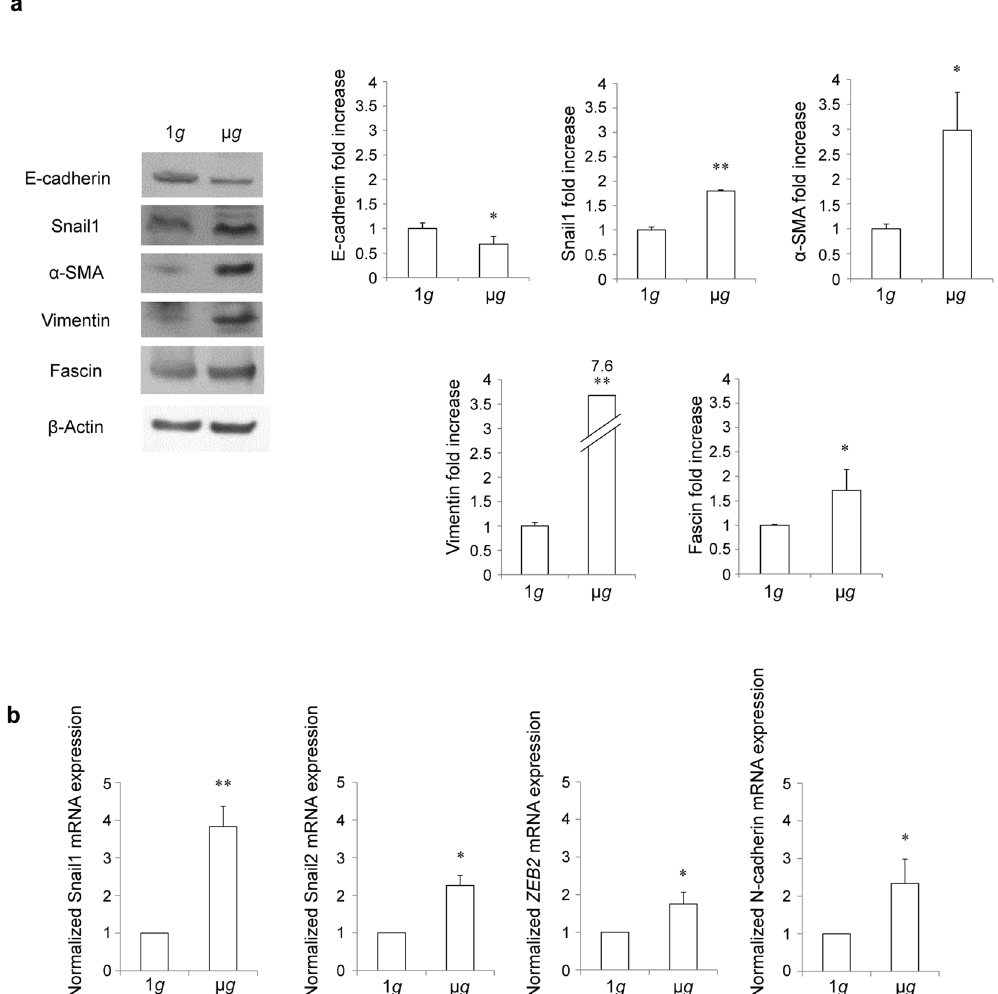
Figure 3. Simulated microgravity induces EMT in keratinocytes. HaCaT cells were exposed to μ g or kept at 1 g for 24 hours. ( a ) Western blot analysis shows, in μ g cells, a reduction of the epithelial marker E-cadherin and an increase of fascin and of the mesenchymal markers α -SMA and vimentin as well as of the EMT-related transcription factor Snail1. The equal loading was assessed using anti- β actin antibody. For the densitometric analysis, the values were normalized, expressed as fold increase and reported in graph as mean value ± SD (n = 3). ( b ) RT-PCR in cells treated as above shows that the mRNA transcript levels of Snail1, Snail2 and ZEB2 and N-cadherin are increased in simulated microgravity-treated cells compared to controls. Results are expressed as mean value ± SD (n = 3). Student’s t test was performed and significance levels have been defined as follows: * p < 0.05 vs 1 g cells; ** p < 0.001 vs 1 g